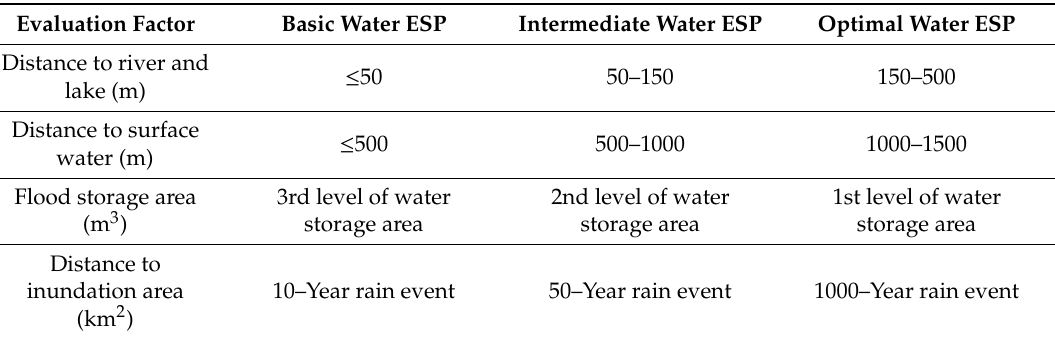
Table 5. Criteria for water ESP